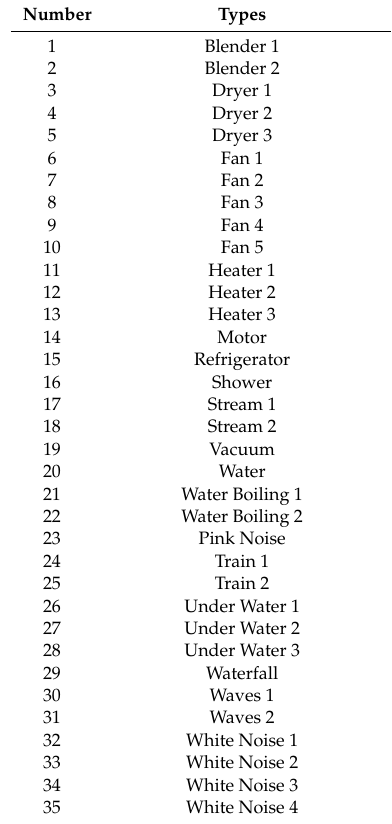
Table 6. Types of test sound